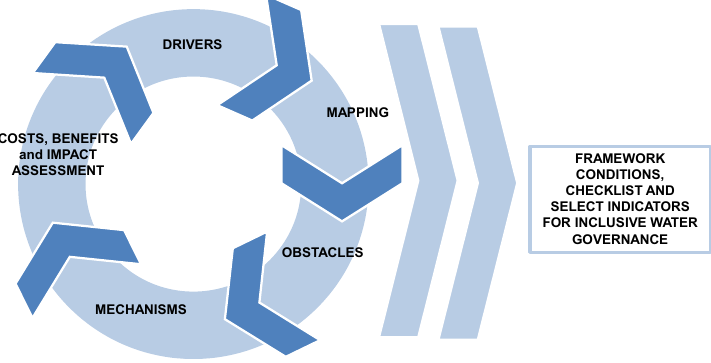
Figure 2. OECD Analytical framework of stakeholder engagement in water governance [23].